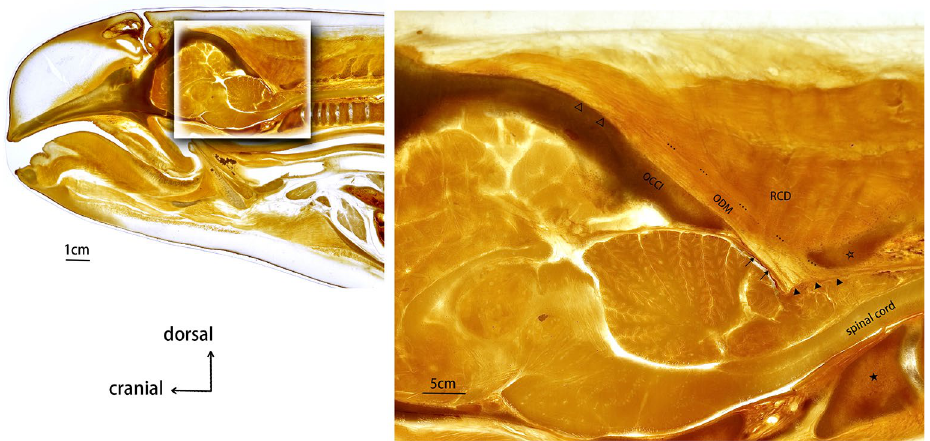
Figure 4. Sagittal section of a P45 plastinated specimen sheet from the suboccipital region of N.asiaeorientalis. OCCI: occiput. RCD: rectus capitis dorsalis. ODM: occipital-dural muscle. three vertebrae. ☆ : fused spinous process. △ : the origination of the occipital-dural muscle. ▲ : termination of